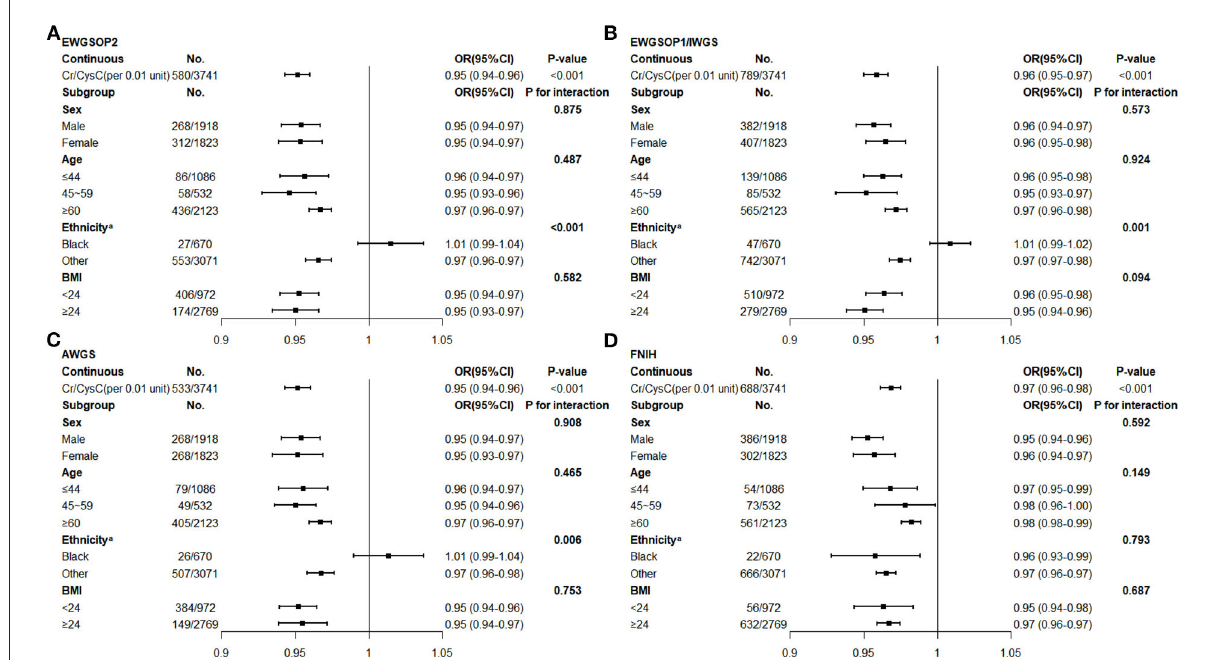
FIGURE1 Multivariate Logistic Regression of Creatinine/Cystatin C and Low Muscle Mass (Weighted) b (A) Low muscle mass defined by the EWGSOP 2 expert consensus. (B) Low muscle mass defined by the EWGSOP 1/IWGS expert consensus. (C) Low muscle mass defined by the AWGS expert consensus. (D) Low muscle mass defined by the FNIH expert consensus. EWGSOP, European Working Group on Sarcopenia Older Persons; IWGS, International Working Group on Sarcopenia; AWGS, Asian Working Group for Sarcopenia; FNIH, Foundation of the National Institute of Health; Cr, creatinine; CysC, Cystatin C; BMI, body mass index. a Adjusted blood urea nitrogen, total cholesterol, neutrophile granulocyte. b Adjusted total fat mass, blood urea nitrogen, total cholesterol, hemoglobin A1c, albumin, hemoglobin, neutrophile